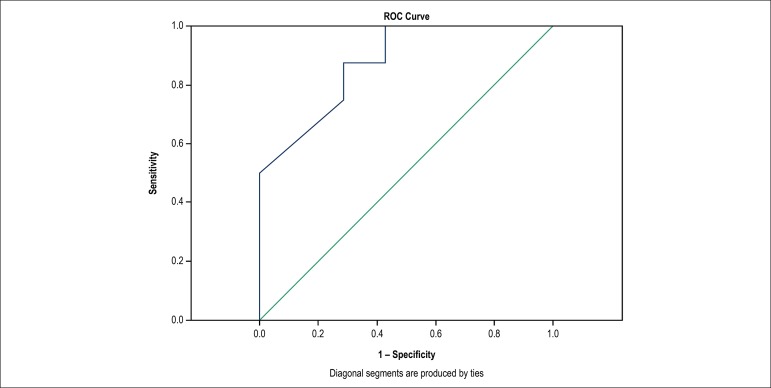
ROC curve to evaluate ability of global strain to identify severe lesion
(> 70%) in any epicardial coronary artery. Area under the ROC curve
0.875, with p < 0.014.